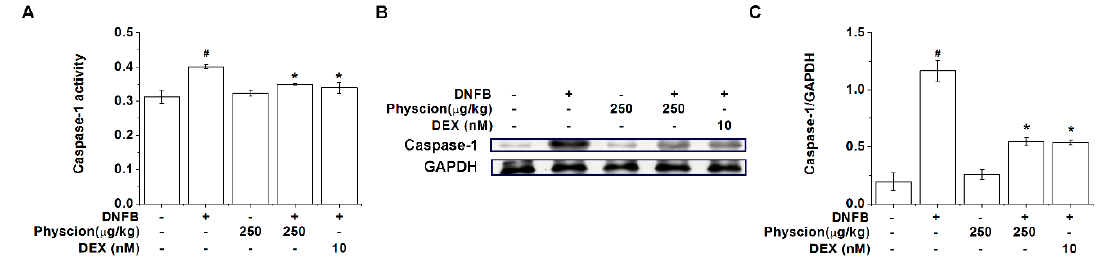
Figure 8. Physcion suppresses caspase-1 activation in AD-like lesional skin. ( A ) Caspase-1 activities in the lesional skin homogenate were analyzed using a caspase-1 colorimetric assay kit. ( B ) Representative immunoblots are shown in the lesional skin homogenate. ( C ) Each relative intensity of protein levels was quantified by densitometry and shown as caspase-1 / GAPDH. # p < 0.05 vs. a vehicle group. * p < 0.05 vs. a DNFB control group.